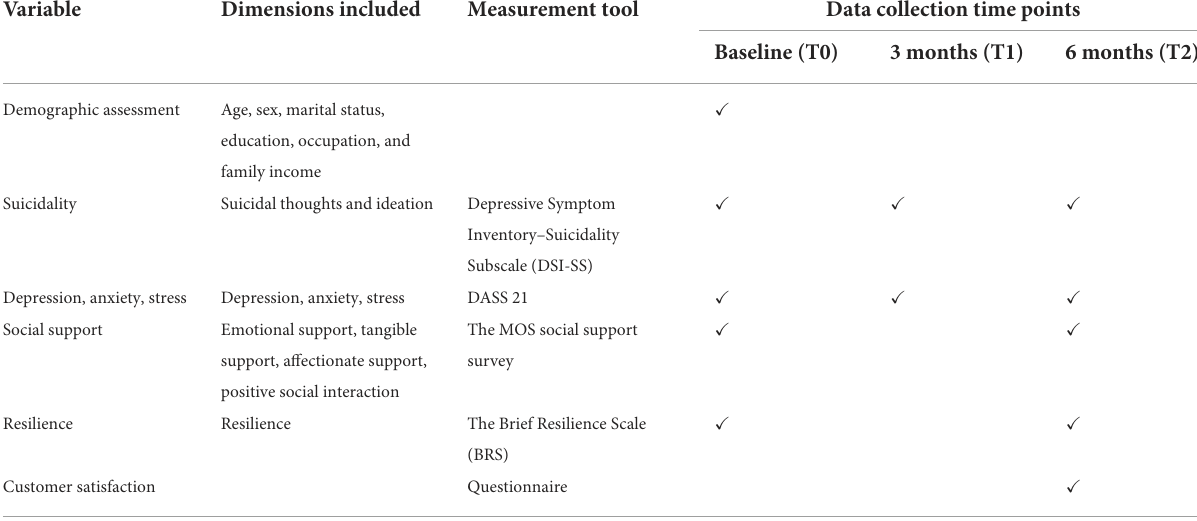
TABLE 1 Measurement domains and data collection time points.